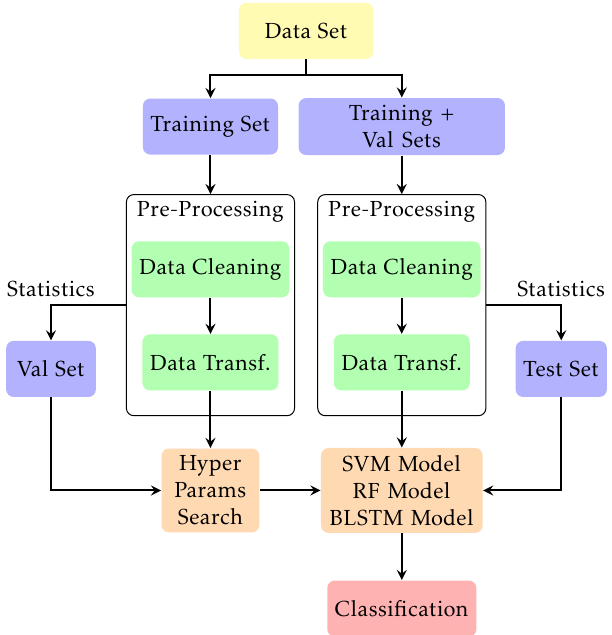
Figure 7. Flow chart diagram illustrating the steps of our work